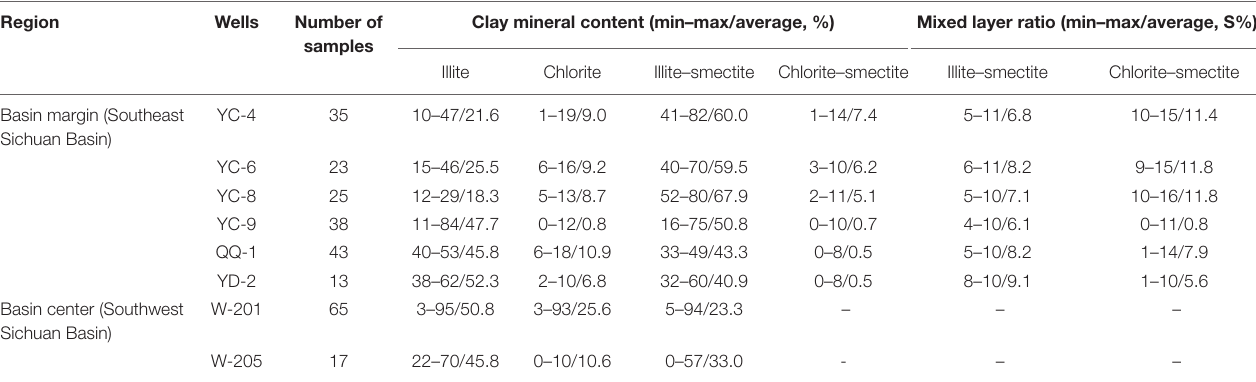
TABLE 3 | Clay mineral compositions of the Longmaxi Formation shale in the Sichuan Basin (XRD).